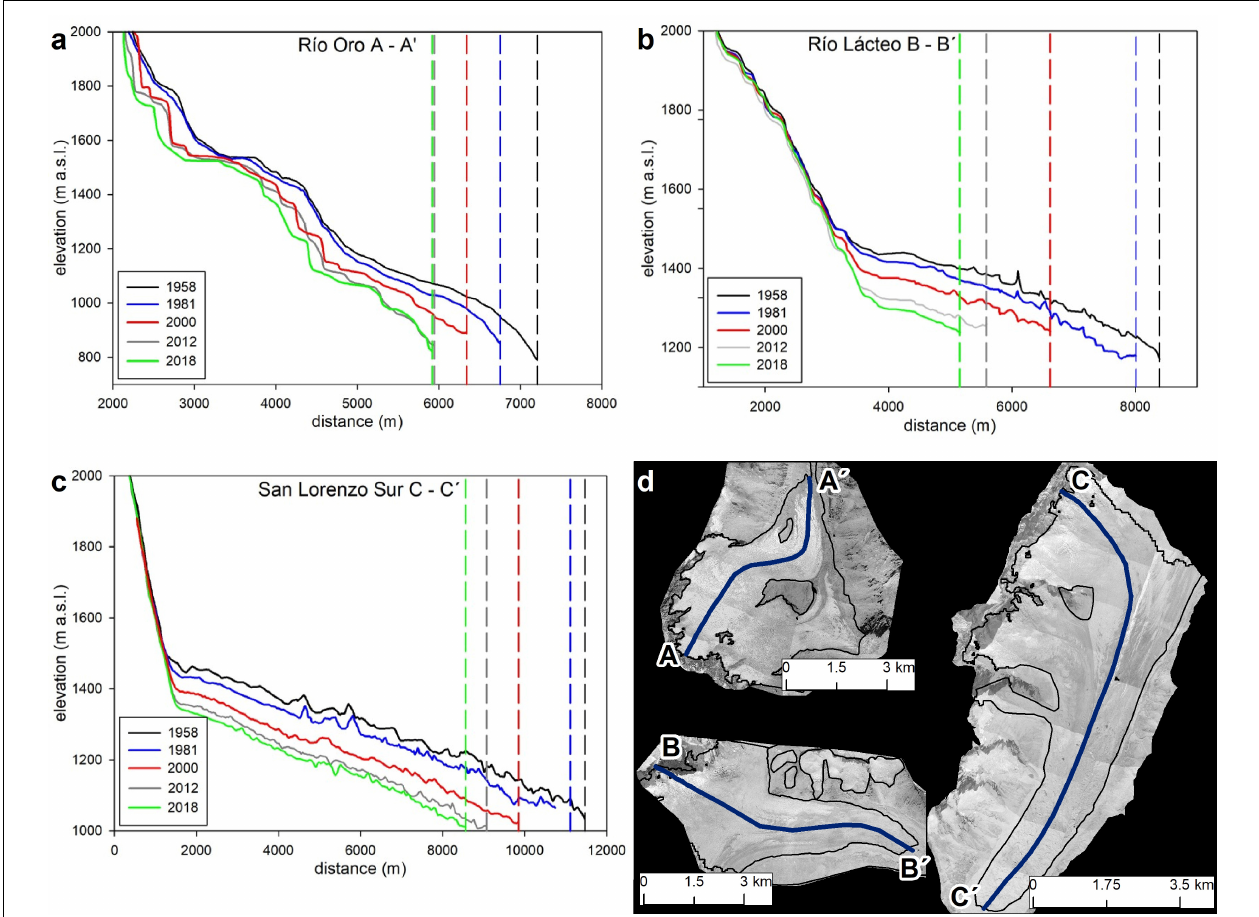
FIGURE 4 | Glacier elevation changes below 2000 m a.s.l. along longitudinal profiles (d) of Río Oro (a) , Río Lácteo (b) and San Lorenzo Sur (c) . The dashed lines represent glacier frontal positions and in the case of Río Lácteo and San Lorenzo Sur, depict the expansion of proglacial lakes.